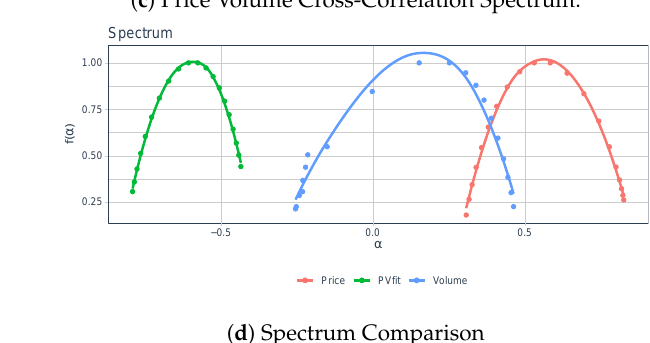
( c ) Price Volume Cross-Correlation Spectrum.